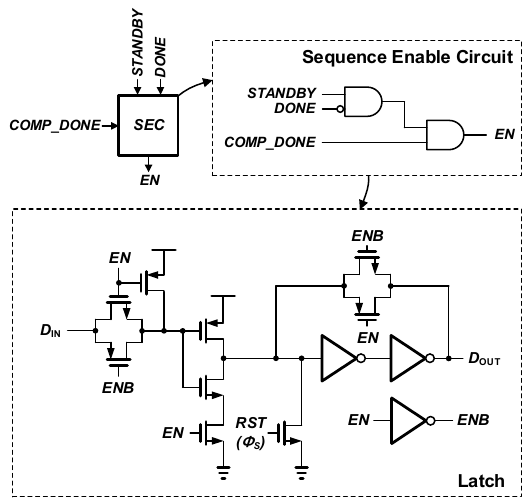
Figure 11. The block and timing diagram of the asynchronous SAR logic.